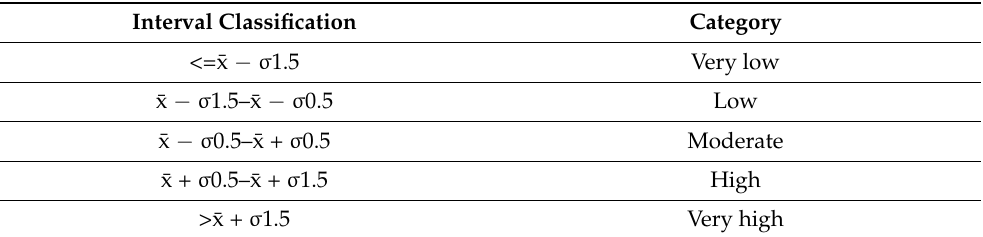
Figure 4. Summary diagram of components of the contagion risk map. Table 1. Interval classification. Own elaboration.